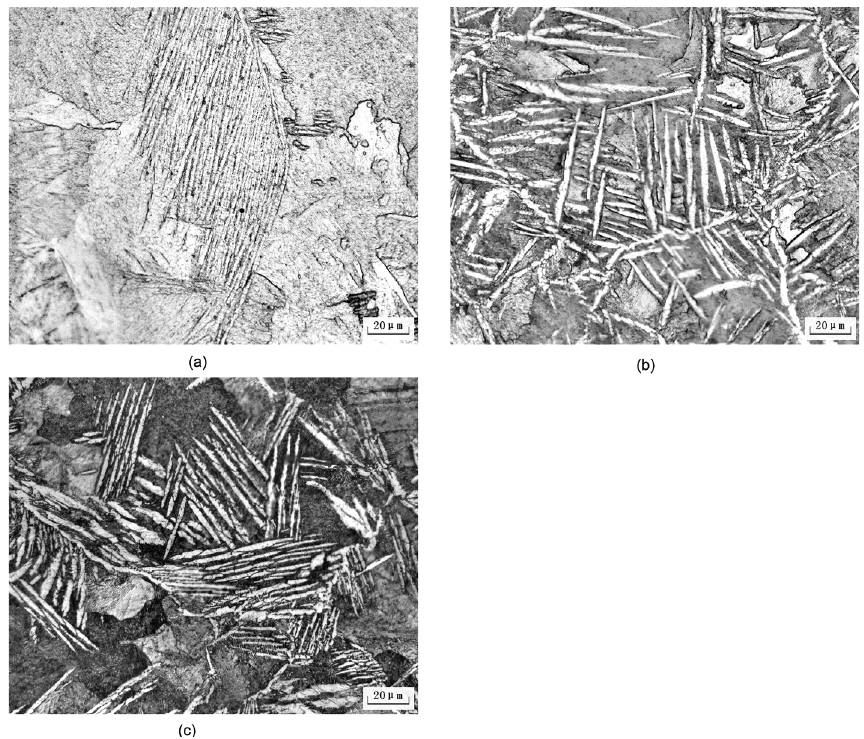
Figure 5: Images of grain boundary after forged at different temperature (a) 1000 ℃ , (b) 1050 ℃ , (c) 1100 ℃ .